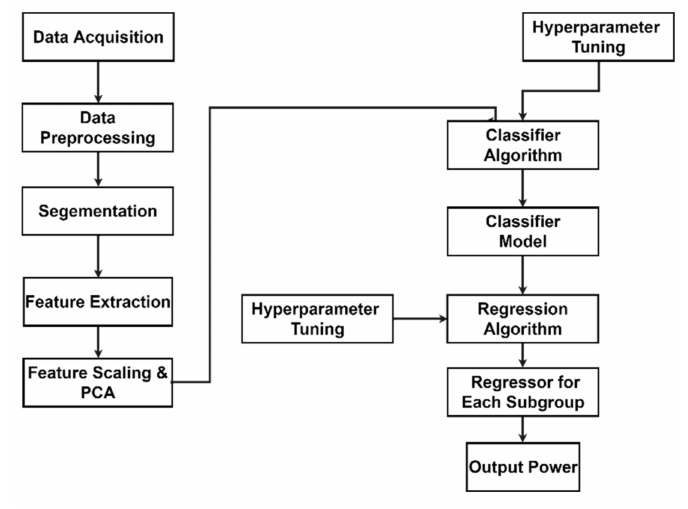
Figure 5. Schematic diagram of the proposed